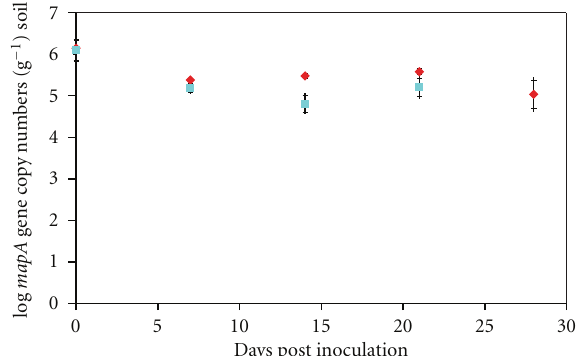
Figure 1: Comparison between the detection of C. jejuni strain 6824 mapA gene copies in soil following the di ff erent inoculation methods in experiments A (red diamonds) and B (turquoise squares). Error bars represent standard deviations from 5 replicate samples and 3 di ff erent real-time PCR reactions per